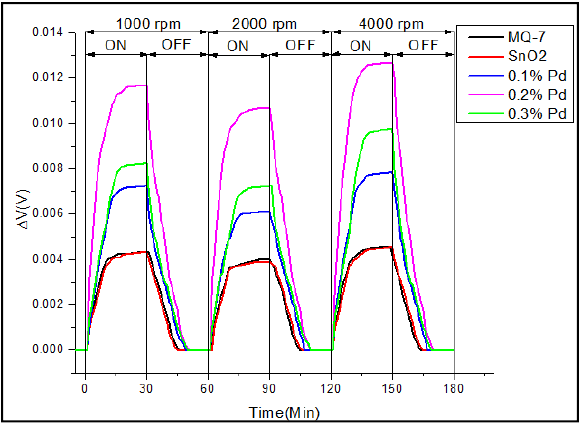
Figure 10. Change in voltage for eight sensor array of pure SnO 2 as well as with different concentrations 0.1%, 0.2%, 0.3% of palladium and commercial CO sensor MQ-7, @1000 rpm, 2000 and 4000 rpm.